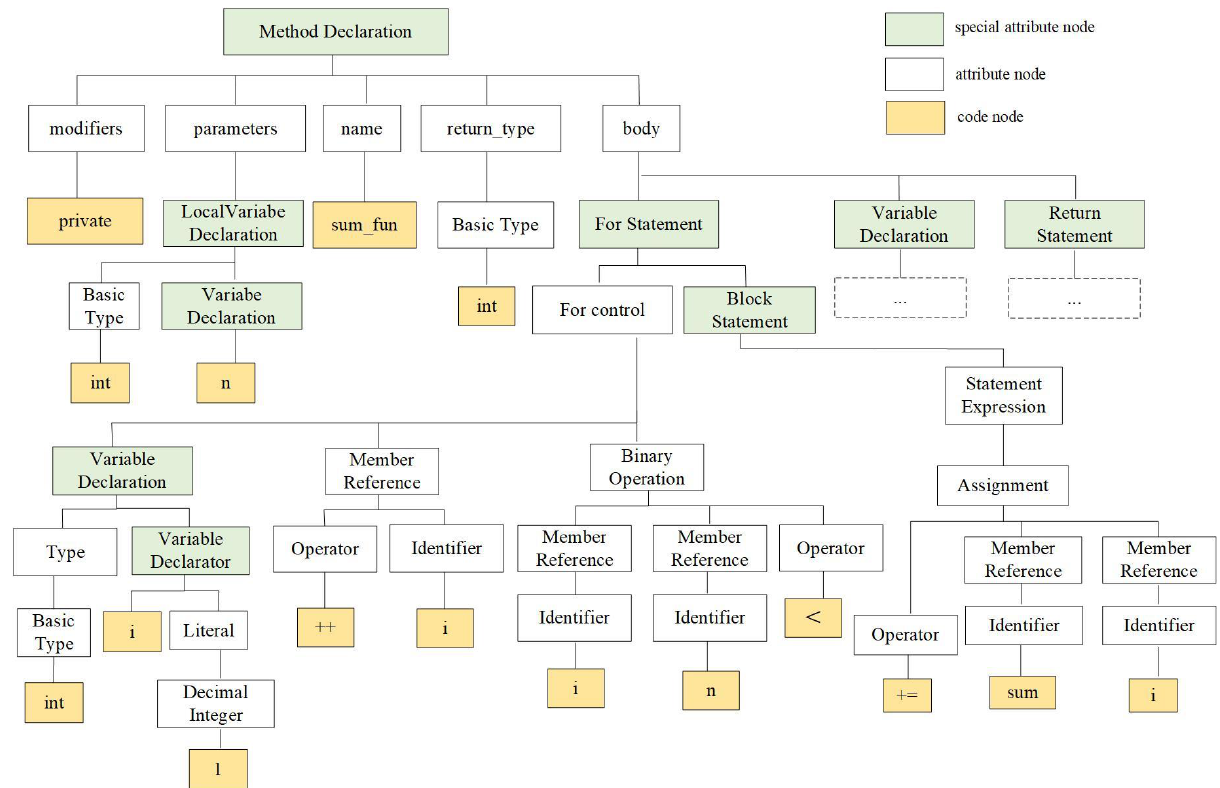
Figure 2. The original abstract syntax tree of code fragment sum _ fun 1. java . In the abstract syntax tree, the green , white and yellow boxes represent special attribute nodes, attribute nodes and code nodes, respectively. Too many attribute nodes in the tree result in overcomplexity of the tree